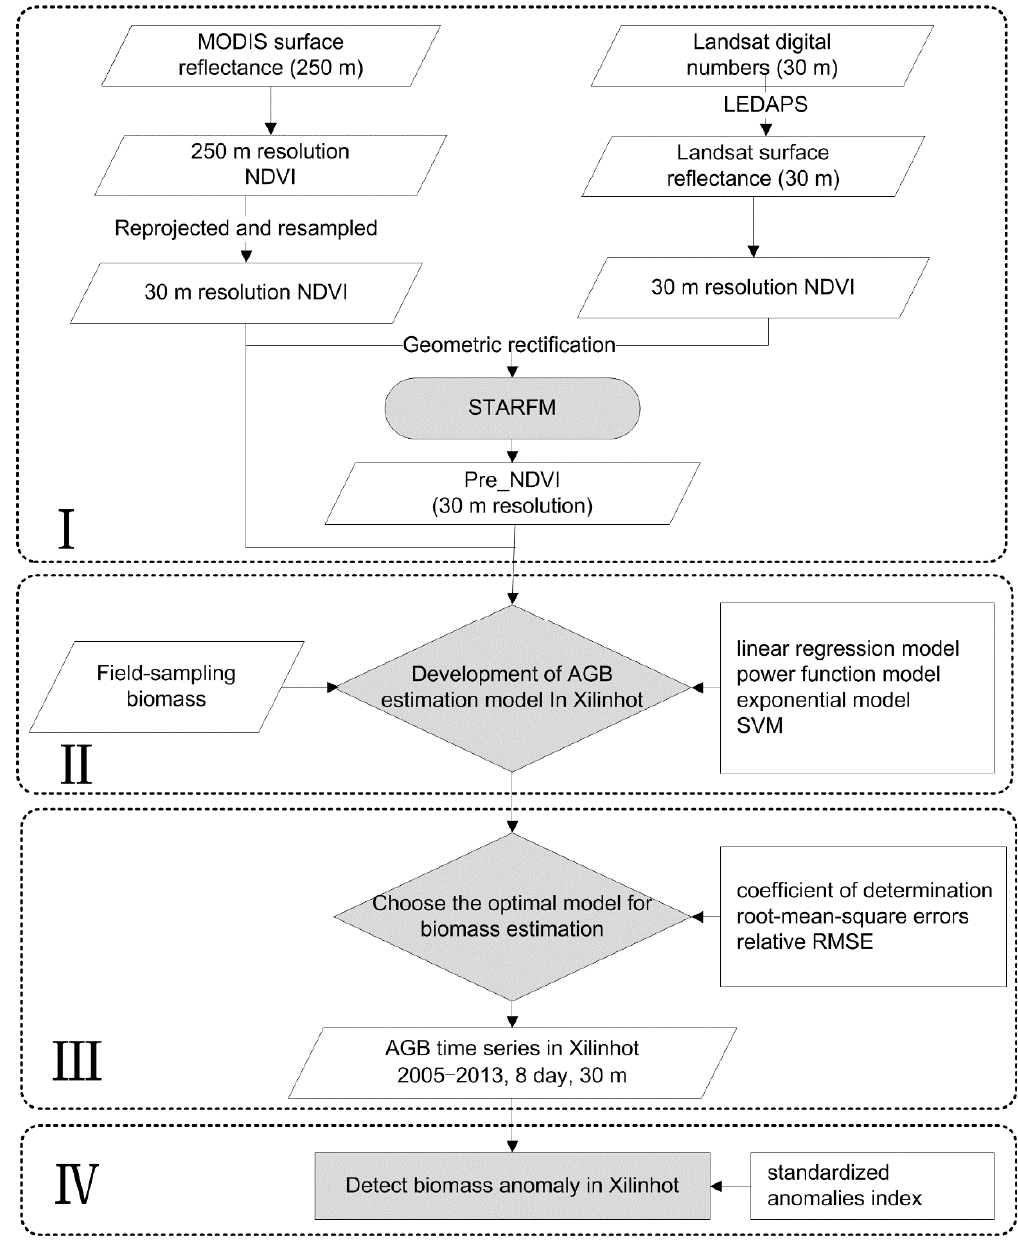
Figure 2. Procedures for developing the aboveground biomass (AGB) estimation model. Pre_NDVI represents the synthetic NDVI series.